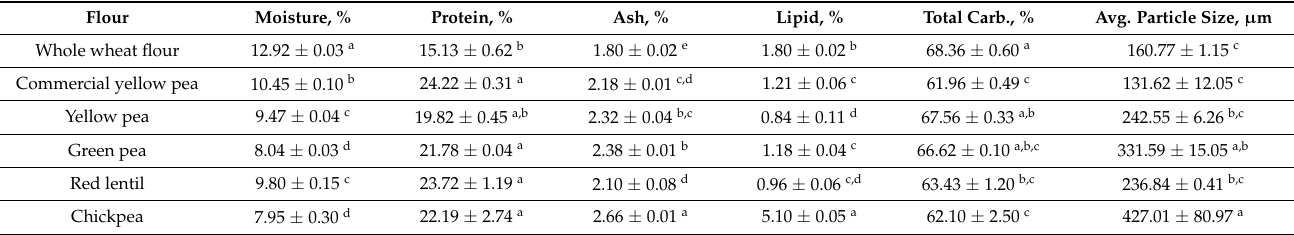
Table 1. Proximate composition (as-is) and average particle size of whole wheat and pulse